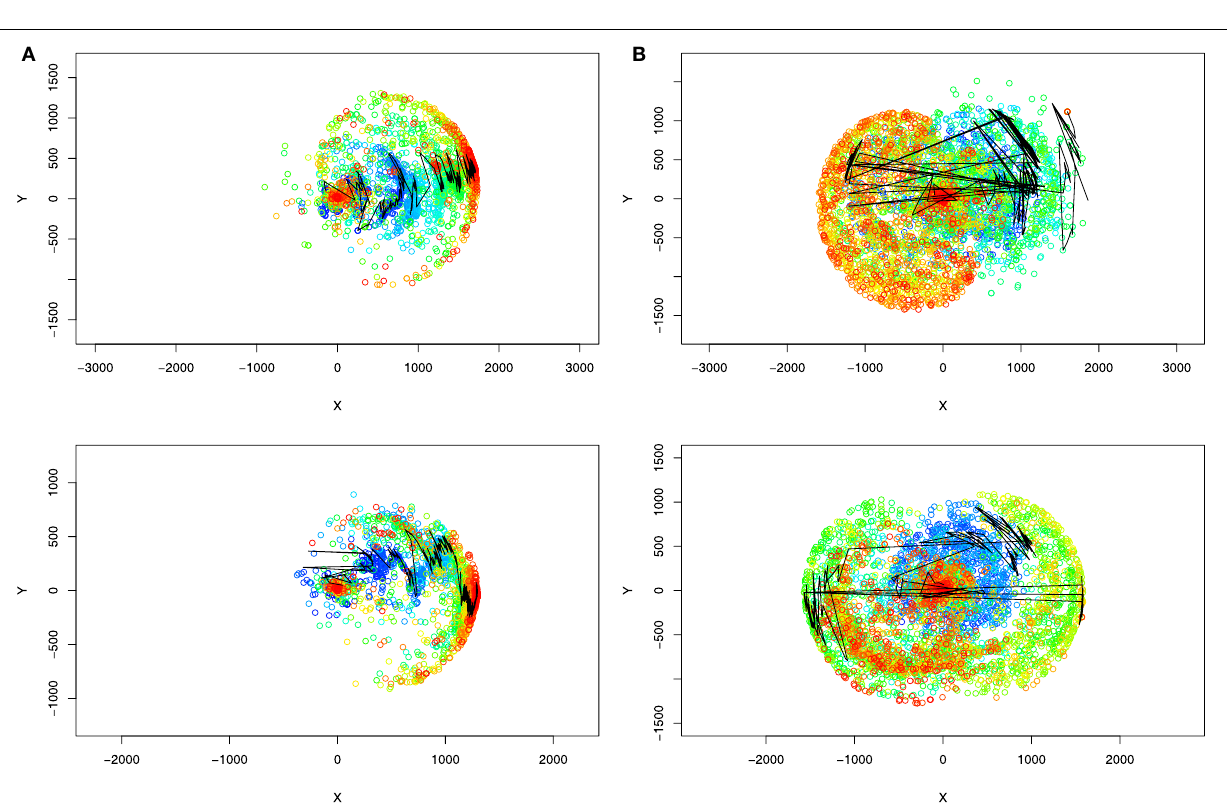
FIGURE 8 | Evolution of aquatic animats: comparison of phenotype space coverage over evolutionary time when evolving with two search algorithms in the experiments with oscillation-driven actuation (see Figure 6A for corresponding fitness plots) . The top row corresponds to the best run in each type of experiment, and the bottom row corresponds to the run that resulted in the median quality individual. Each point in a plot represents the final location of an individual who was evaluated during a given evolutionary run (a randomly chosen 1% individuals is shown). The color of a circle represents generation at which an individual was created: blue correspond to the beginning of a run, red to the end, and green to the middle. The line connects points corresponding to the best individual (in terms of objective fitness value) in every generation. (A) NEAT search, (B) novelty